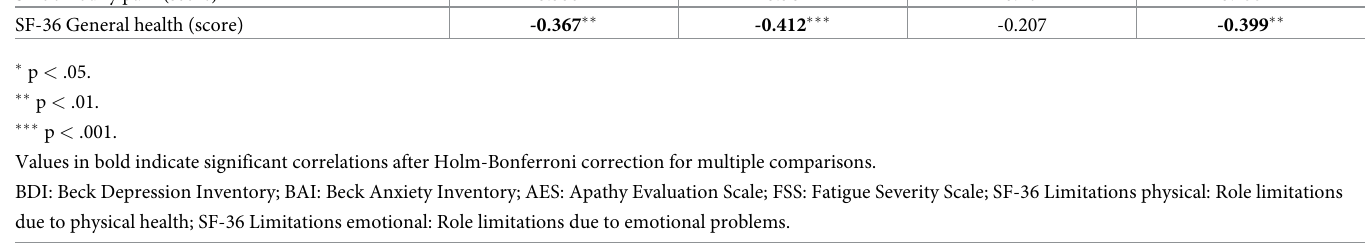
“emotional well-being” and “bodily pain” SF-36 scales in the CIS group. The results are pre- sented in Table 3. These associations remained significant in the covariate-adjusted regression